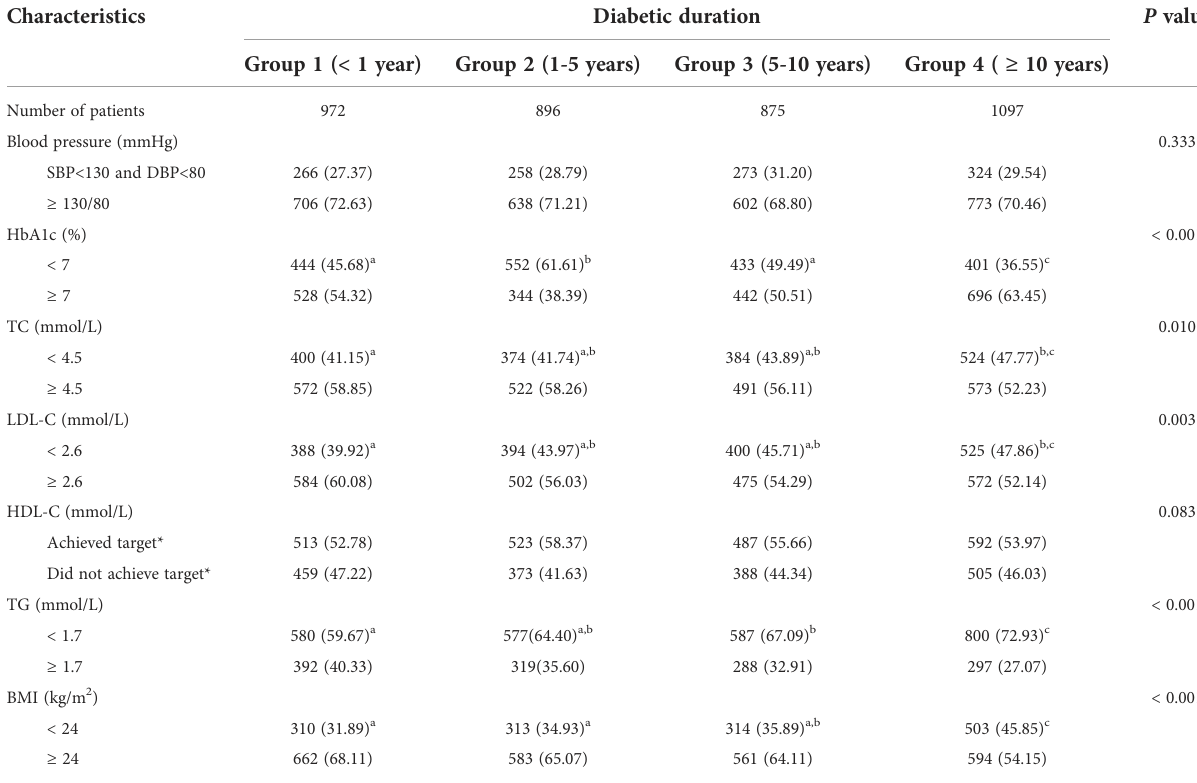
TABLE 2 Control rates of elderly T2DM patients with different diabetic durations.